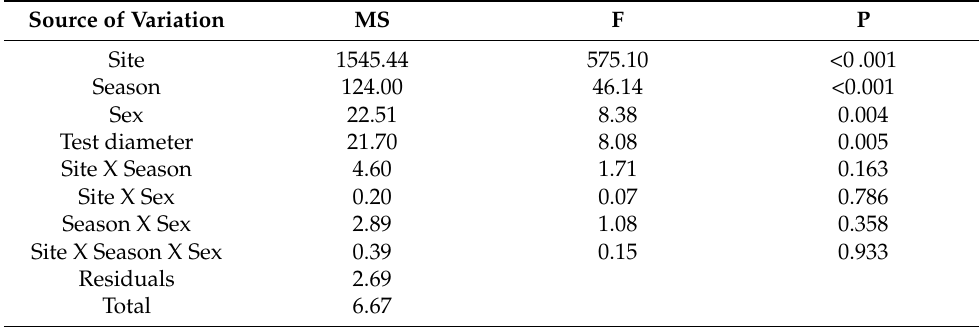
the surveyed Arbacia lixula population gonadosomatic index